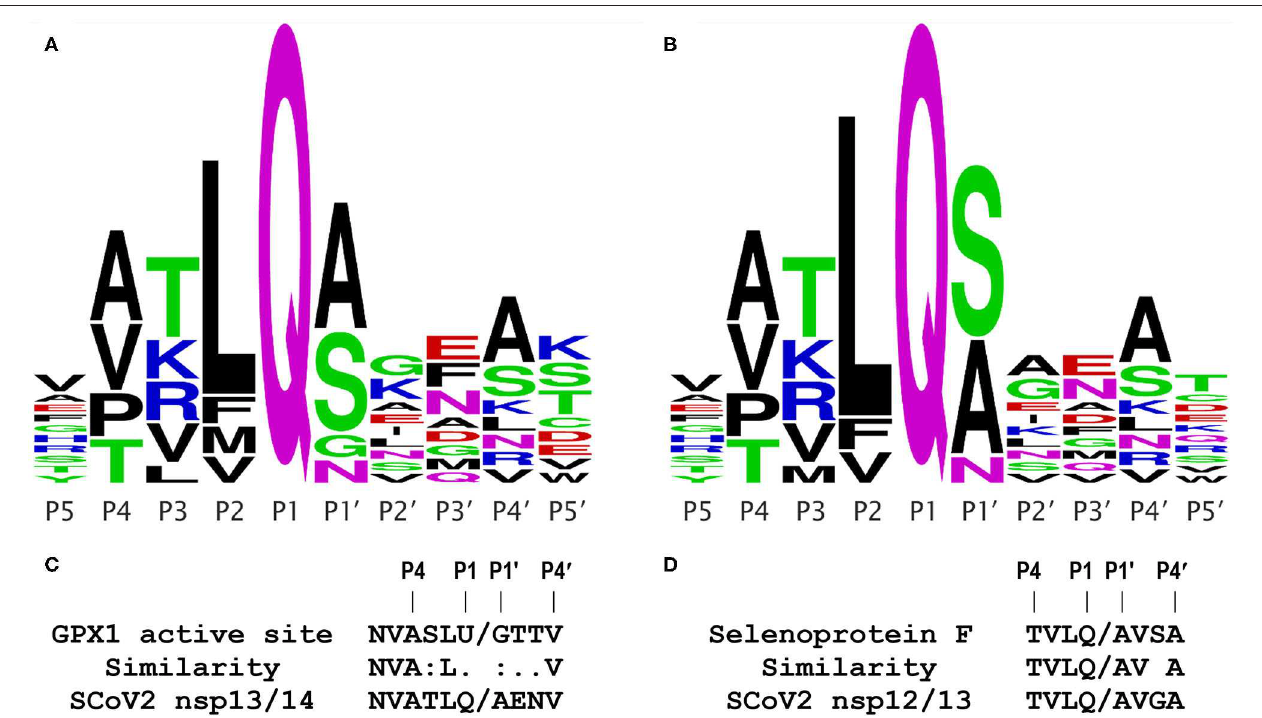
FIGURE 1 | Coronavirus M pro cleavage site consensus sequence logo plots and comparisons. Logo plots from multiple alignments of the known M pro cleavage sites are shown for the 2003 SCoV (A) and 2019 SCoV2 (B) . The height of a letter at each position reflects its probability in the alignment; each of the logos shown represents the consensus of 11 M pro cleavage sites from a single virus. Plots were generated using WebLogo (weblogo.berkeley.edu/logo.cgi), from the alignments in Figure S1 . (C) Comparison of the GPX1 active site sequence containing selenocysteine (U) to the known SCoV2 M pro cleavage site at the nsp13/14 junction; this site is identical in the 2003 and 2019 coronaviruses. (D) Comparison of a predicted M pro cleavage site in human selenoprotein F to a known SCoV2 M pro cleavage site at the nsp12/13